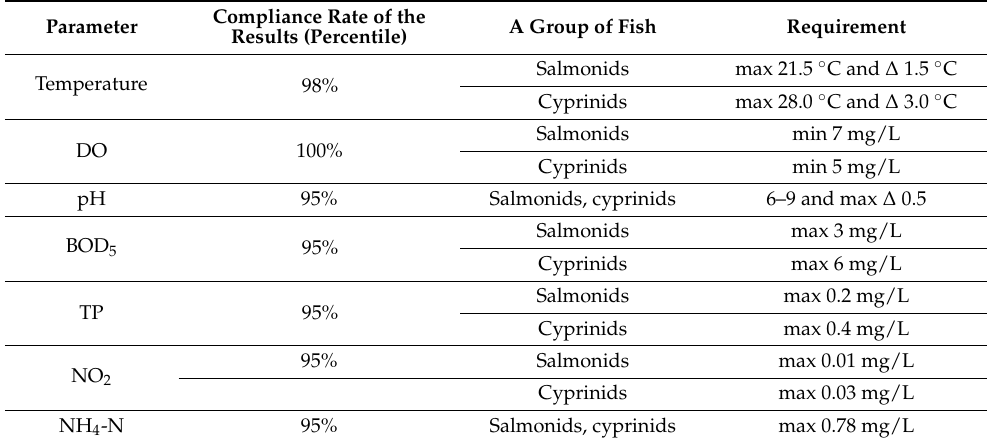
Table 5. The requirements of the conditions for the life of salmonids and cyprinids according to Polish regulations [44].